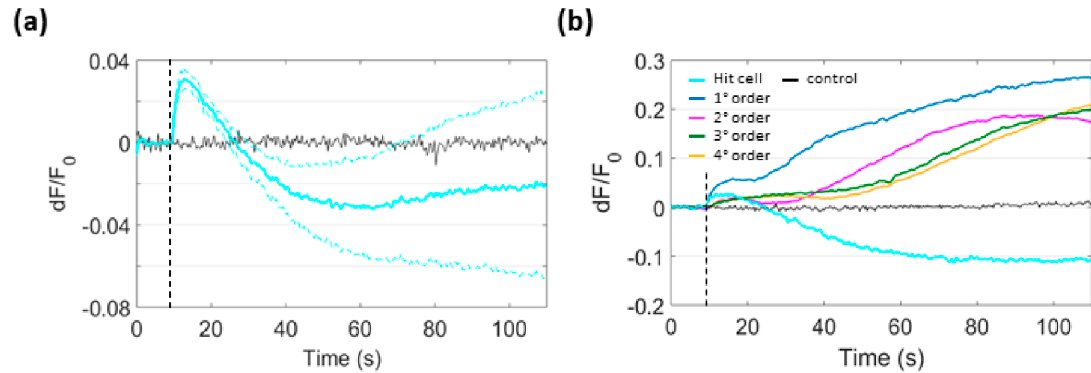
Figure 7. H 2 O 2 production following focal PS activation in B16-F10 cells expressing HyPerRed. ( a ) HyPerRed fluorescence change in the irradiated cell; shown are mean (solid trace) ± s.e.m. (dashed traces) for n = 6 experiments. ( b ) HyPerRed fluorescence change in bystander cells: the experiment shown is representative of n = 3 independent experiments conducted under SS conditions (which all gave similar results). Single-cell dF / F 0 fluorescence traces were computed as average pixel signals within ROIs contouring the whole cell area. Black traces in ( a ) and in ( b ) are representative signals obtained in the absence of PS. Vertical dashed lines mark the onset of laser irradiation.